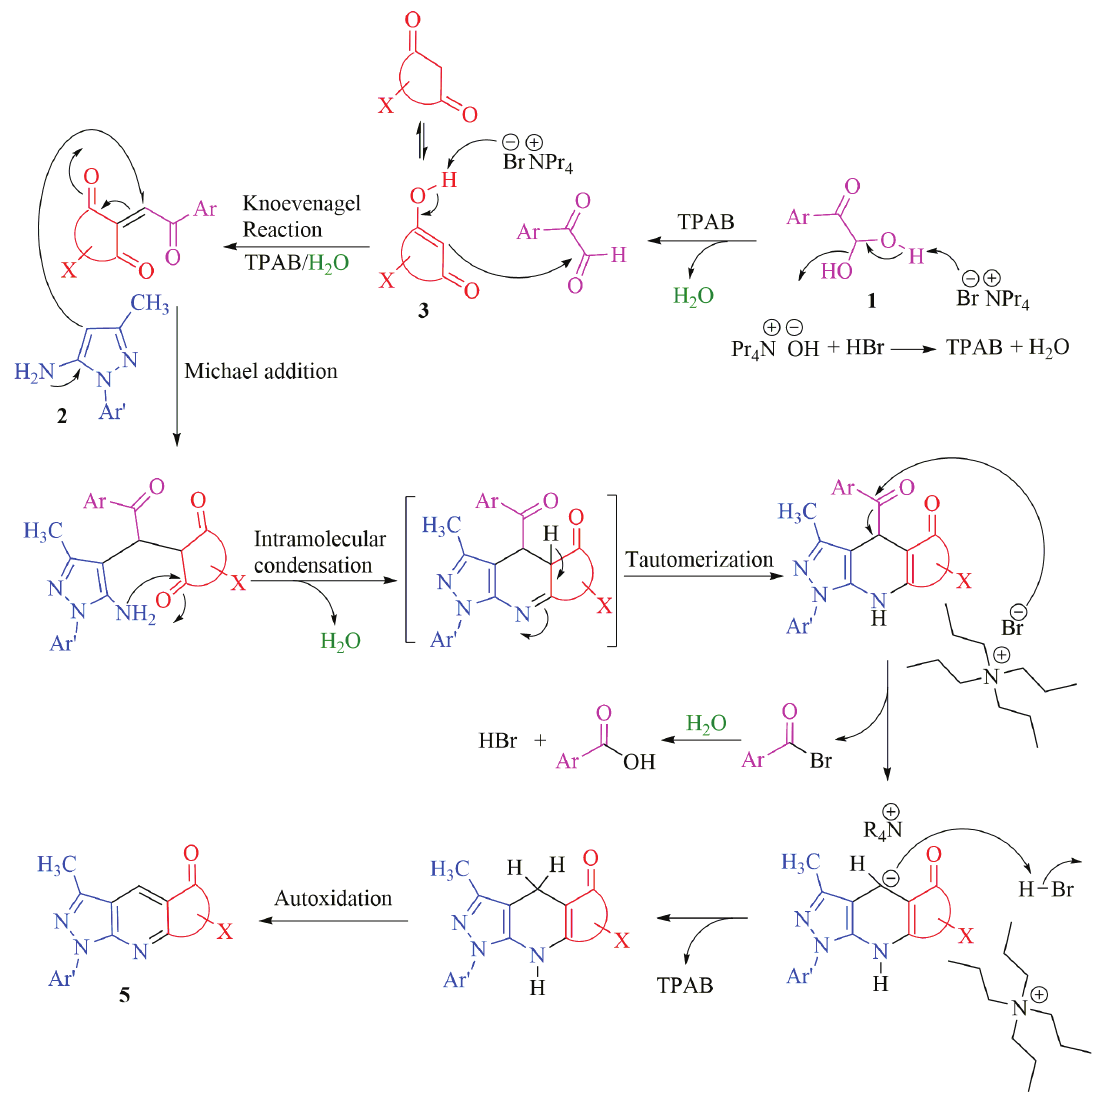
Scheme 2: A plausible mechanistic pathway for the formation of 5 .